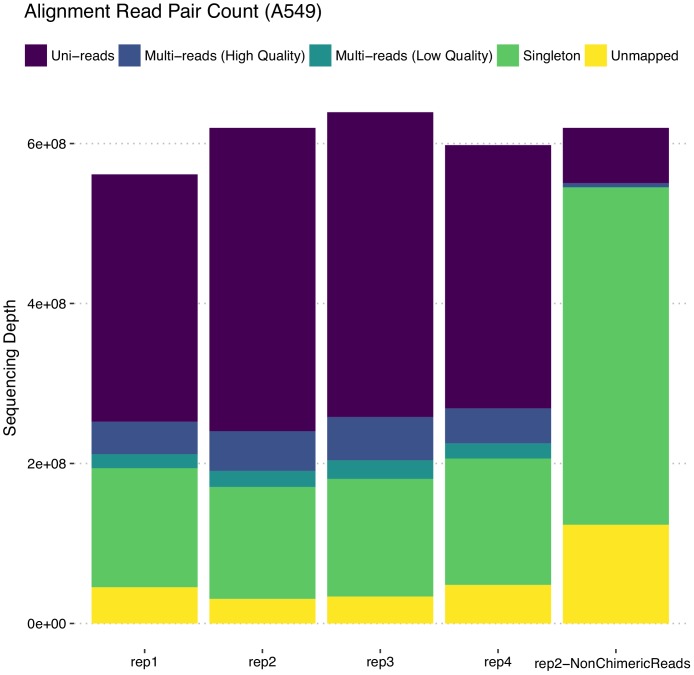
Comparison of read decompositions of ‘rep2’ with ‘rep2-NonChimericReads’ sequencing depths indicates that in the full read length dataset, a large proportion of the uni-reads are due to rescued chimeric reads (i.e., these are Uni- or Multi-reads in rep2 and Singletons in rep2-NonChimericReads).Downstream analysis of trimming experiments beyond evaluating the accuracy of multi-read assignments utilized Uni-reads of rep2 displayed here for deriving gold standard interaction sets.